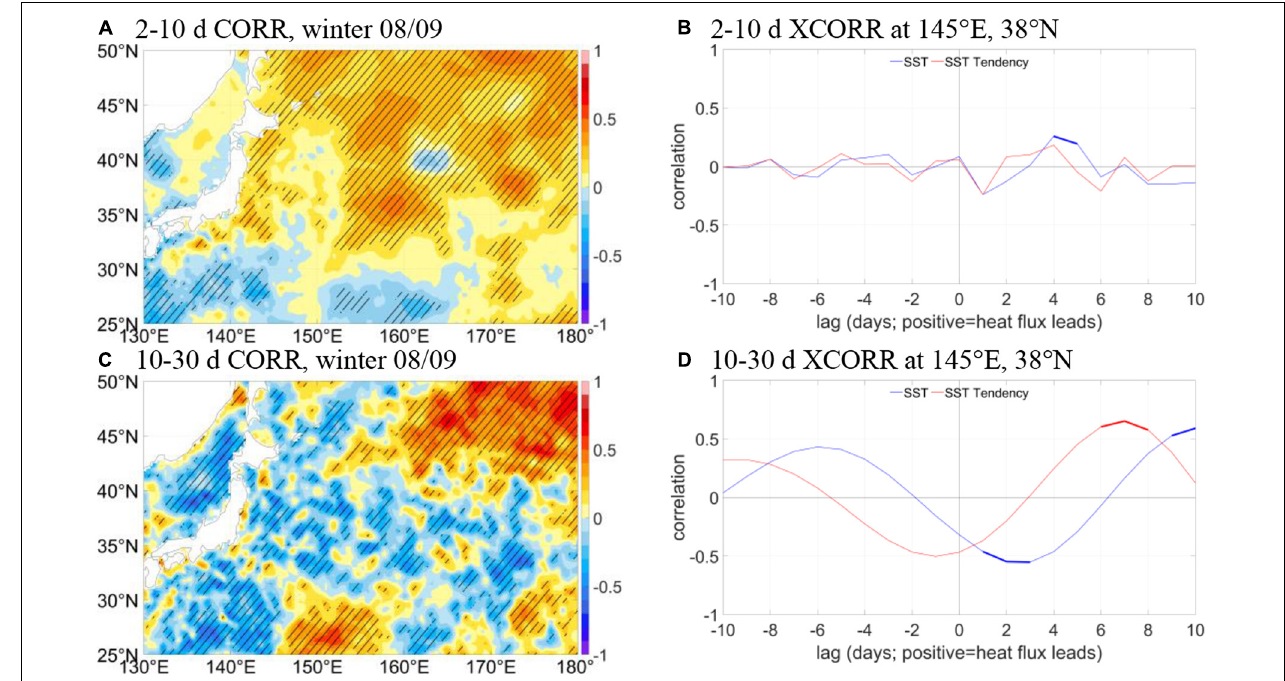
FIGURE 4 | (A) Simultaneous correlation between SST and net heat flux on 2–10 days timescales in winter 2008/09. Hatched areas indicate statistical significance at the 95% level. (B) Cross-correlation between SST and net heat flux at 145 ◦ E, 38 ◦ N on 2–10 days timescales in winter 2008/09. Thick parts of the curves indicate statistical significance at the 95% level. (C) Same as (A) but for 10–30 days timescales. (D) Same as (B) but for 10–30 days timescales. TABLE 1 | Comparison of physical processes in observations, the theoretical model, and the GOTM experiments. Physical process OBS (observation) THEO